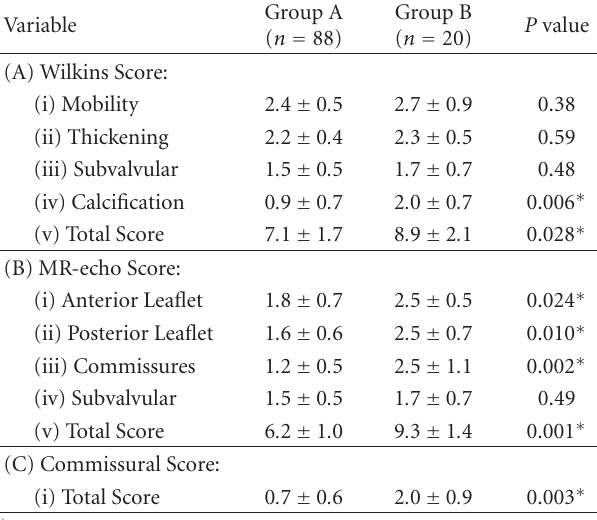
Table 2: Hemodynamic and procedural data. Variable